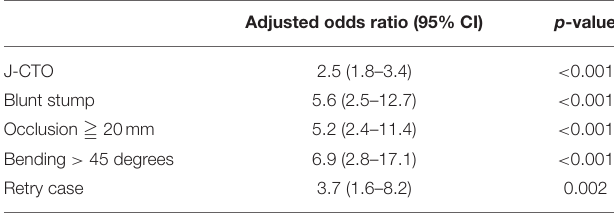
TABLE 3 | Multivariate logistic regression analysis for independent factors associated with overall antegrade procedural